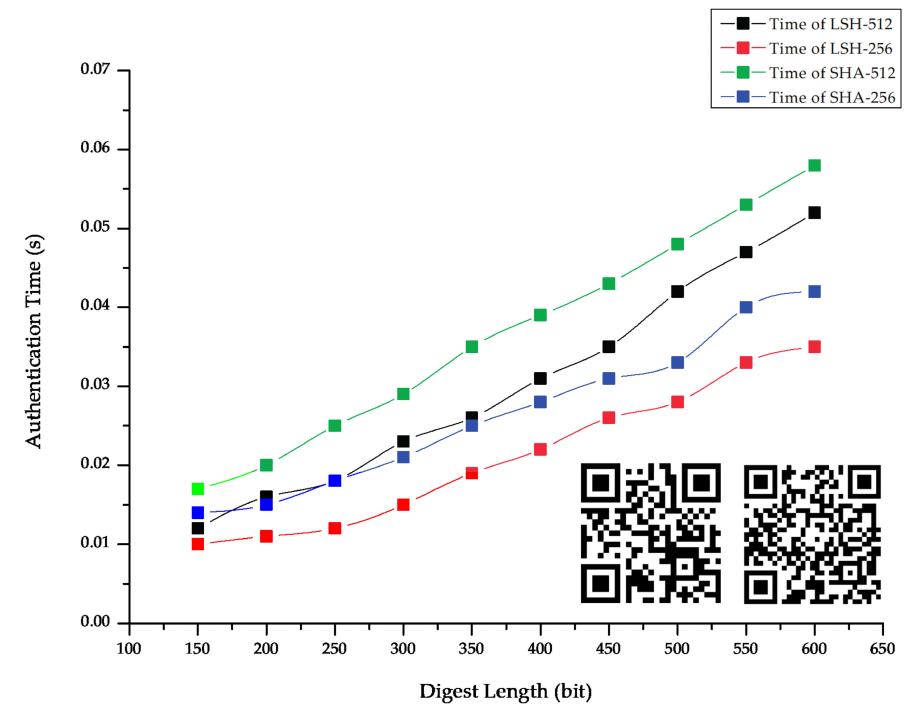
Figure 11. Brief comparative result of LSH and SHA hash functions based on each QR